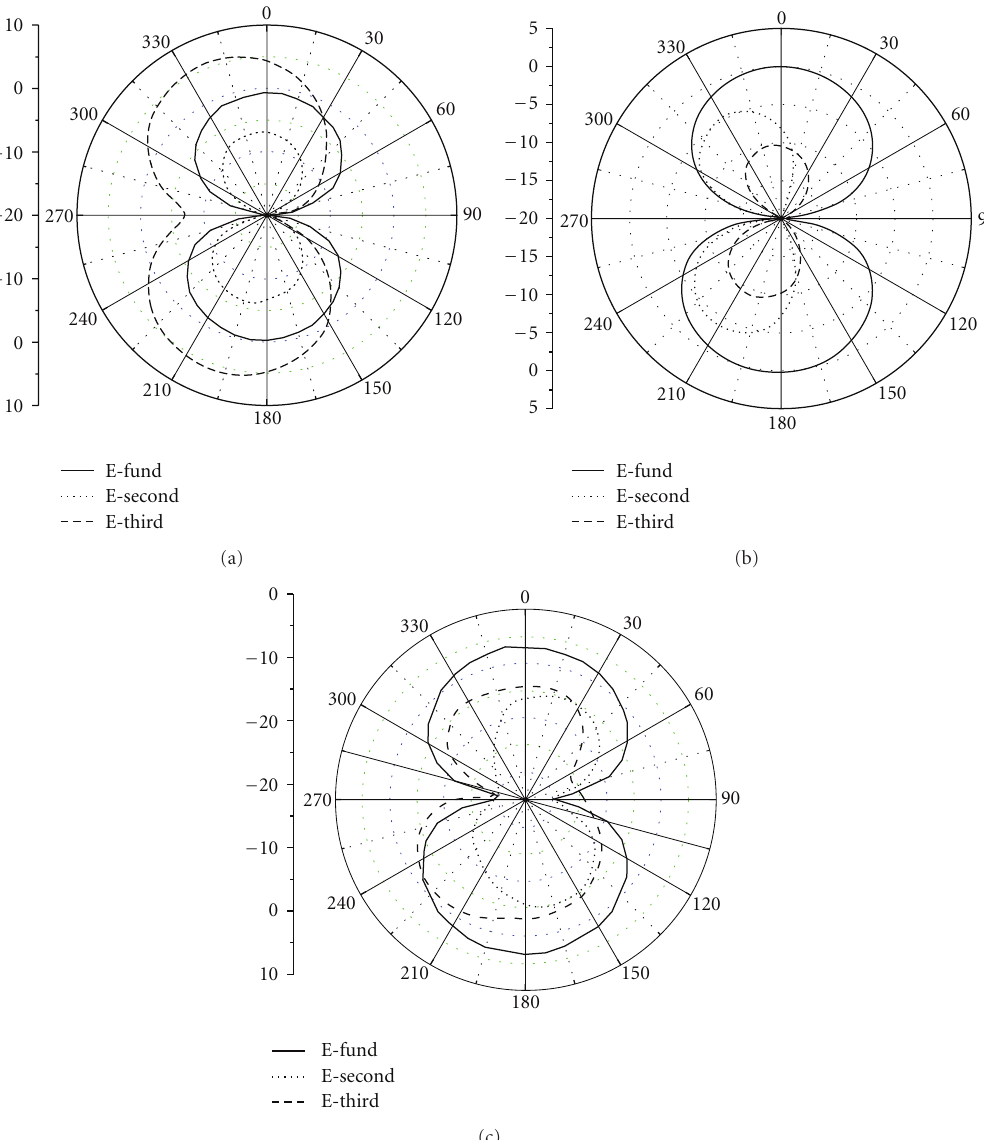
Figure 9: The radiation patterns at di ff erent frequencies for: (a) antenna 1, (b) antenna 2, and (c) antenna